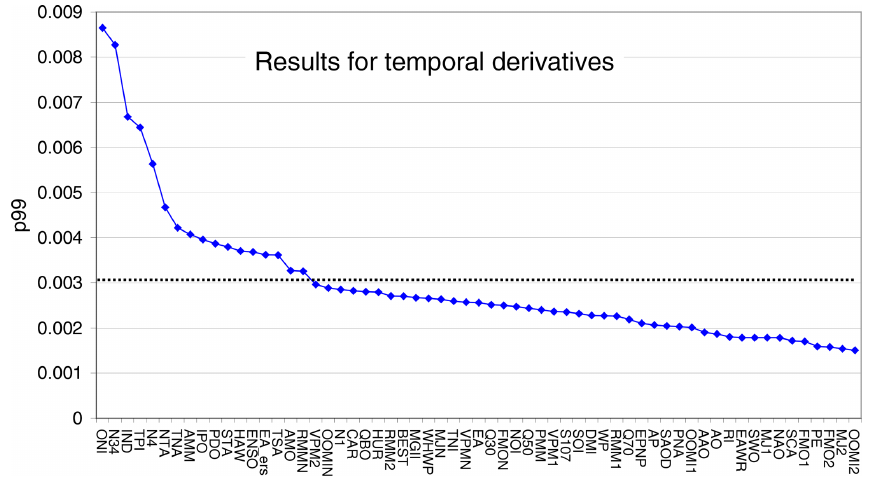
Figure A11. The 99th percentiles (p99) of the delta rms of the derivatives of all indices. The black lines represent the significance threshold. The indices are sorted from highest to lowest p99